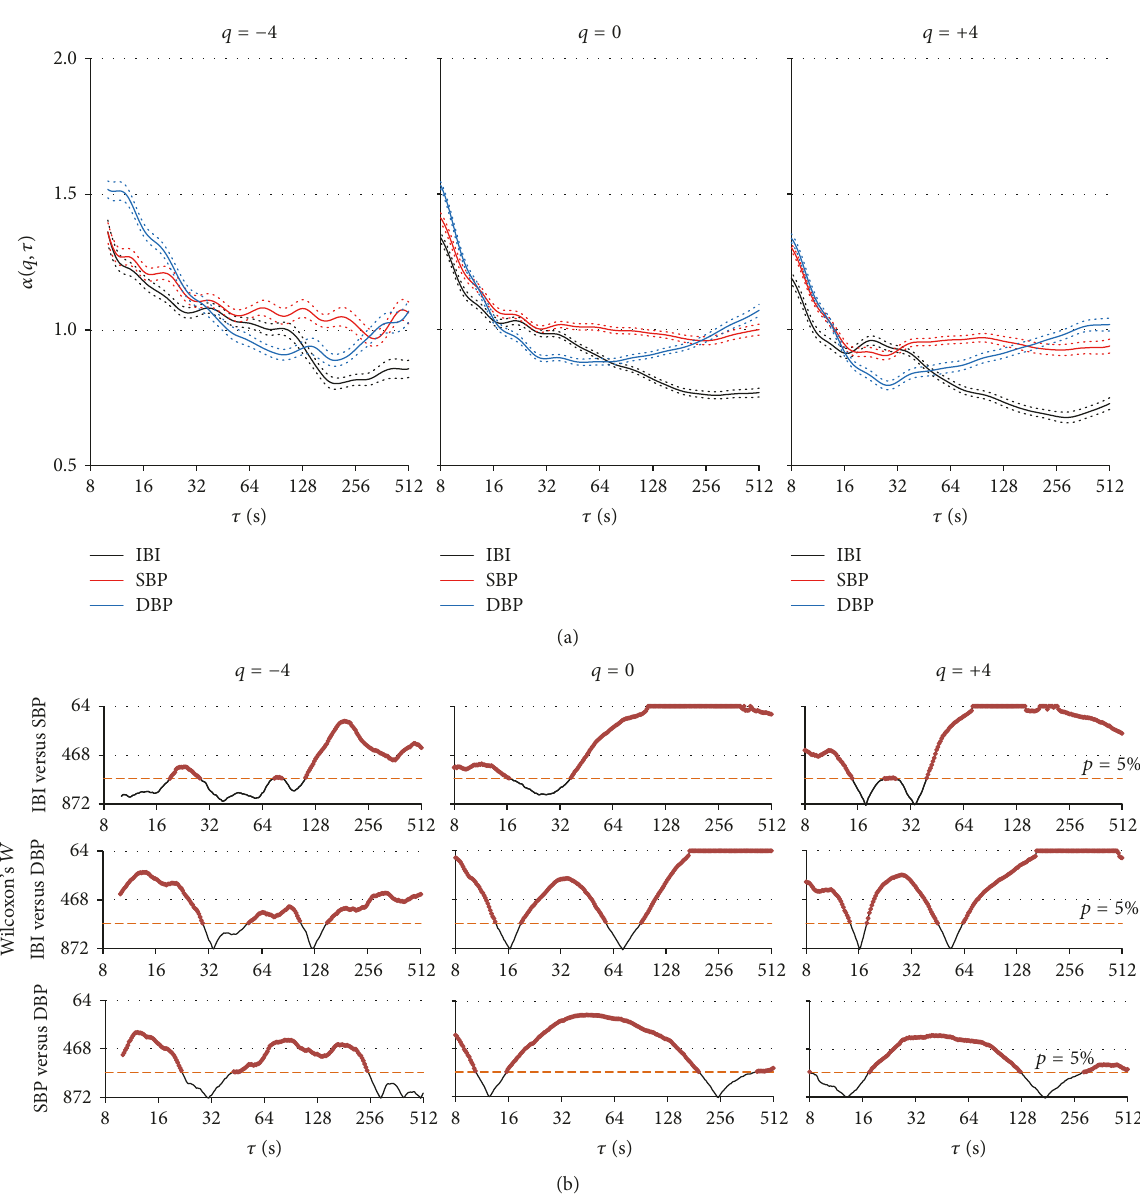
Figure 5: Comparison of 𝛼(𝑞,𝜏) among cardiovascular signals at different q values . (a) Mean ± standard error of the mean over the group ( 𝑁 = 84 ) as function of 𝜏 . (b), from top to bottom : 𝑊 statistics of Wilcoxon’s tests at each scale 𝜏 for comparing IBI and SBP, IBI and DBP, and SBP and DBP. Dashed horizontal lines represent the 5% threshold of statistical significance; 𝑊 values above the threshold are marked by a red dot and indicate statistically significant differences at 𝑝 < 5